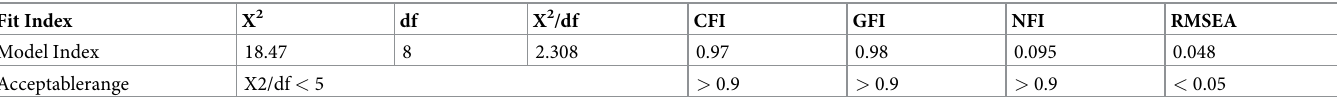
Table 4. Goodnees of fit indecesof empirical path model between health anxiety, COVID-19 phobia, and social